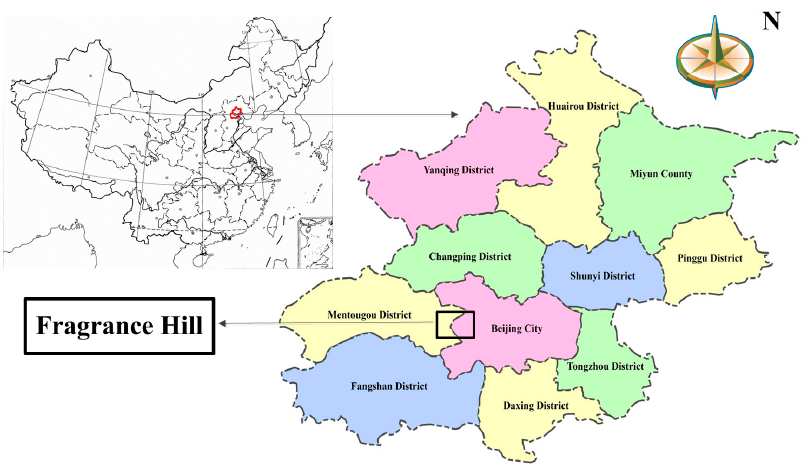
Figure 1. Location of Fragrance Hills, Beijing.